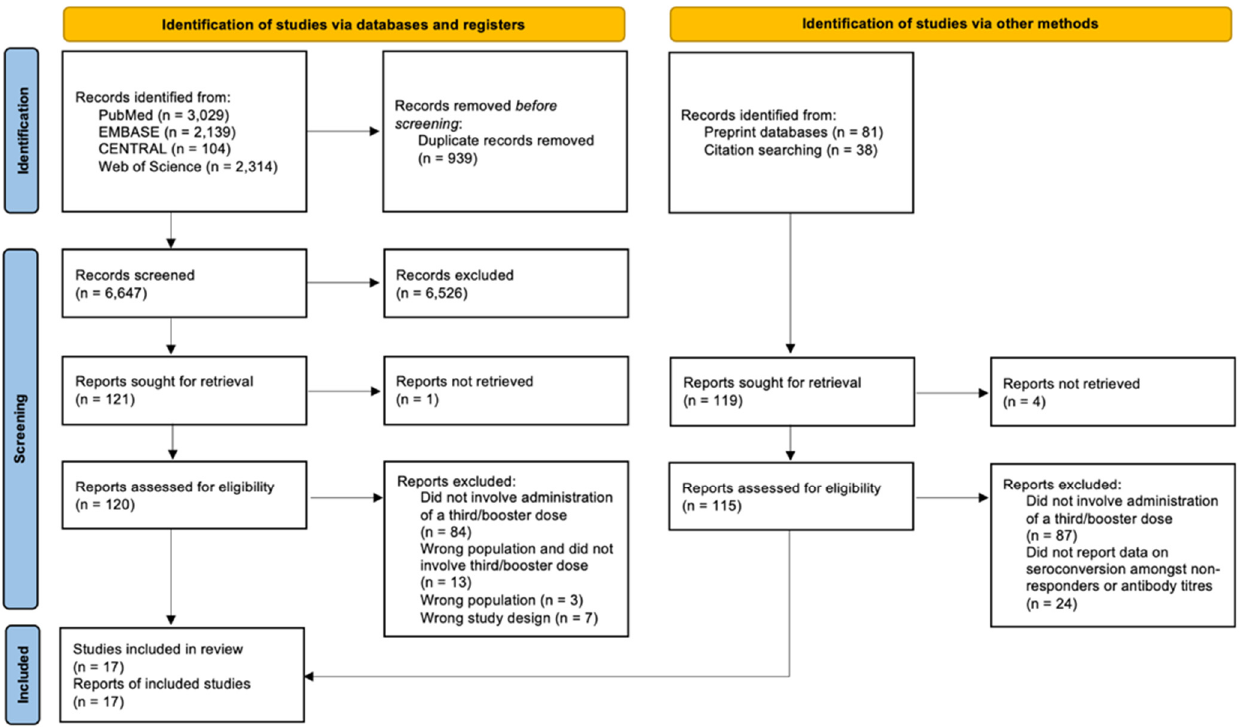
Figure 1. PRISMA flowchart. Figure 1. PRISMA Table 1. Characteristics of included studies.